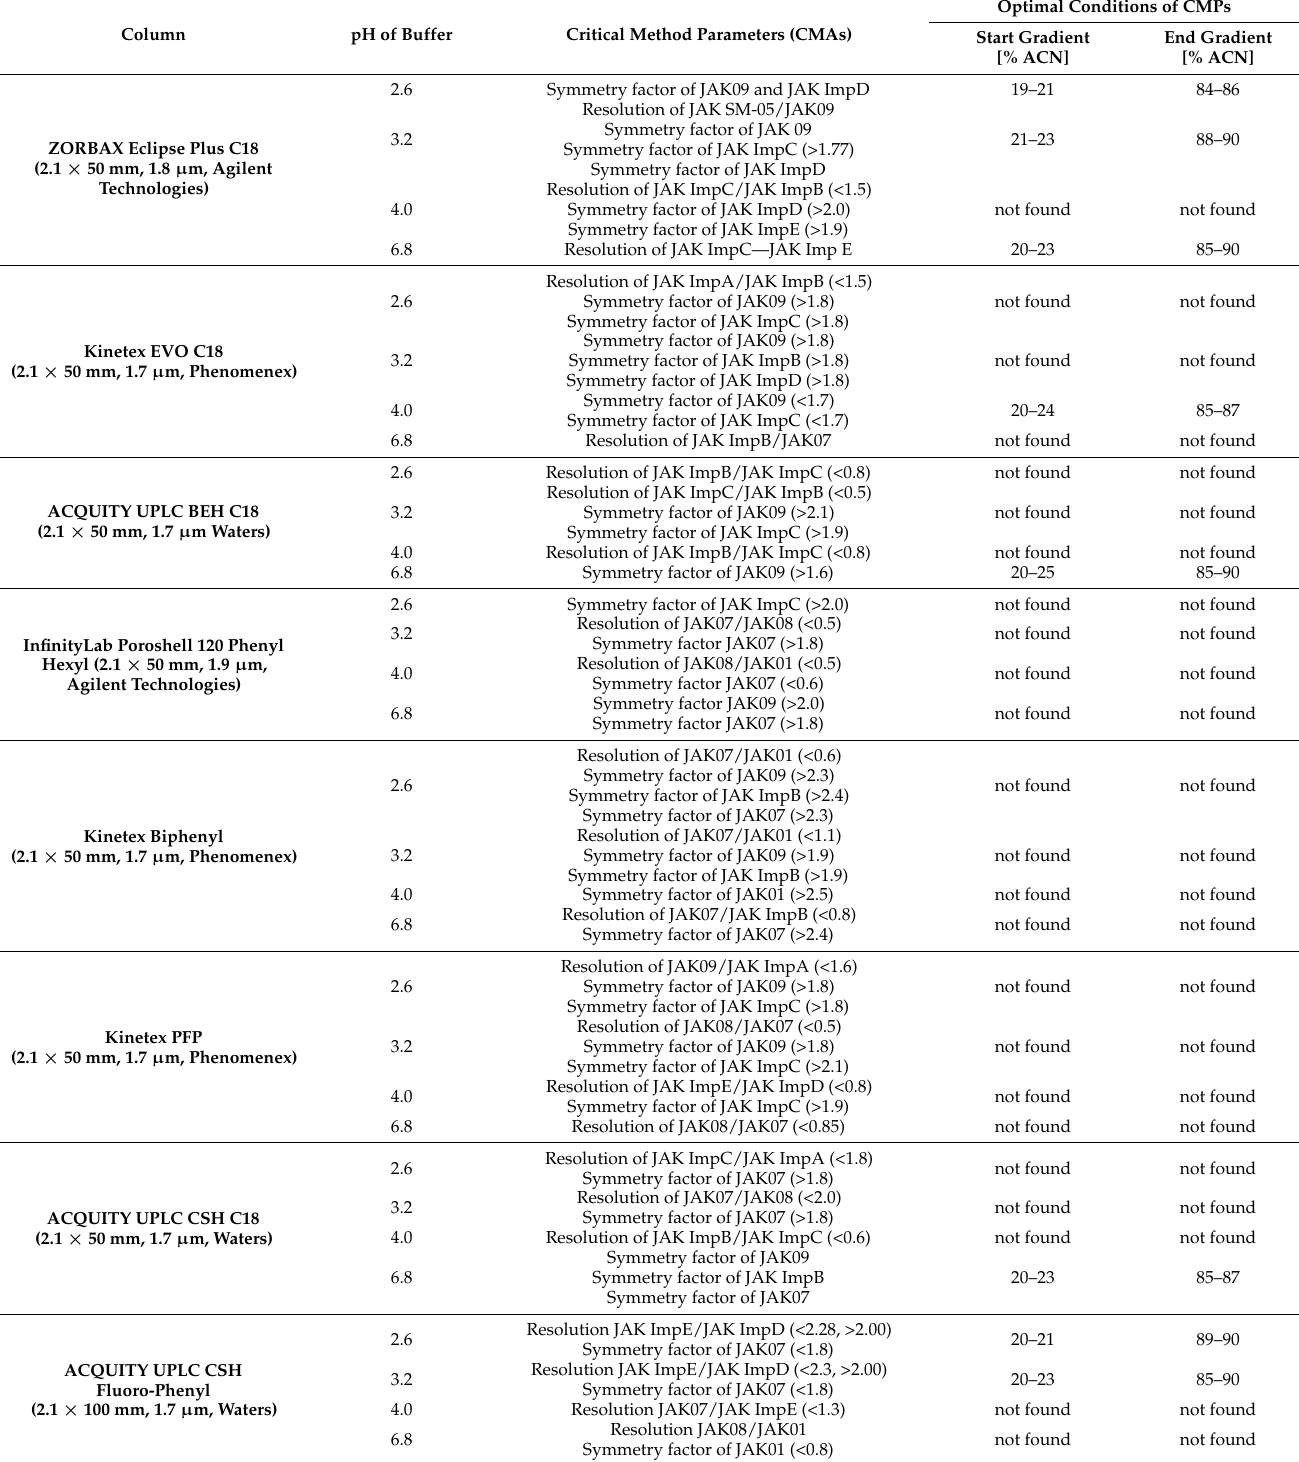
Table 4. Summary of the screening experiments